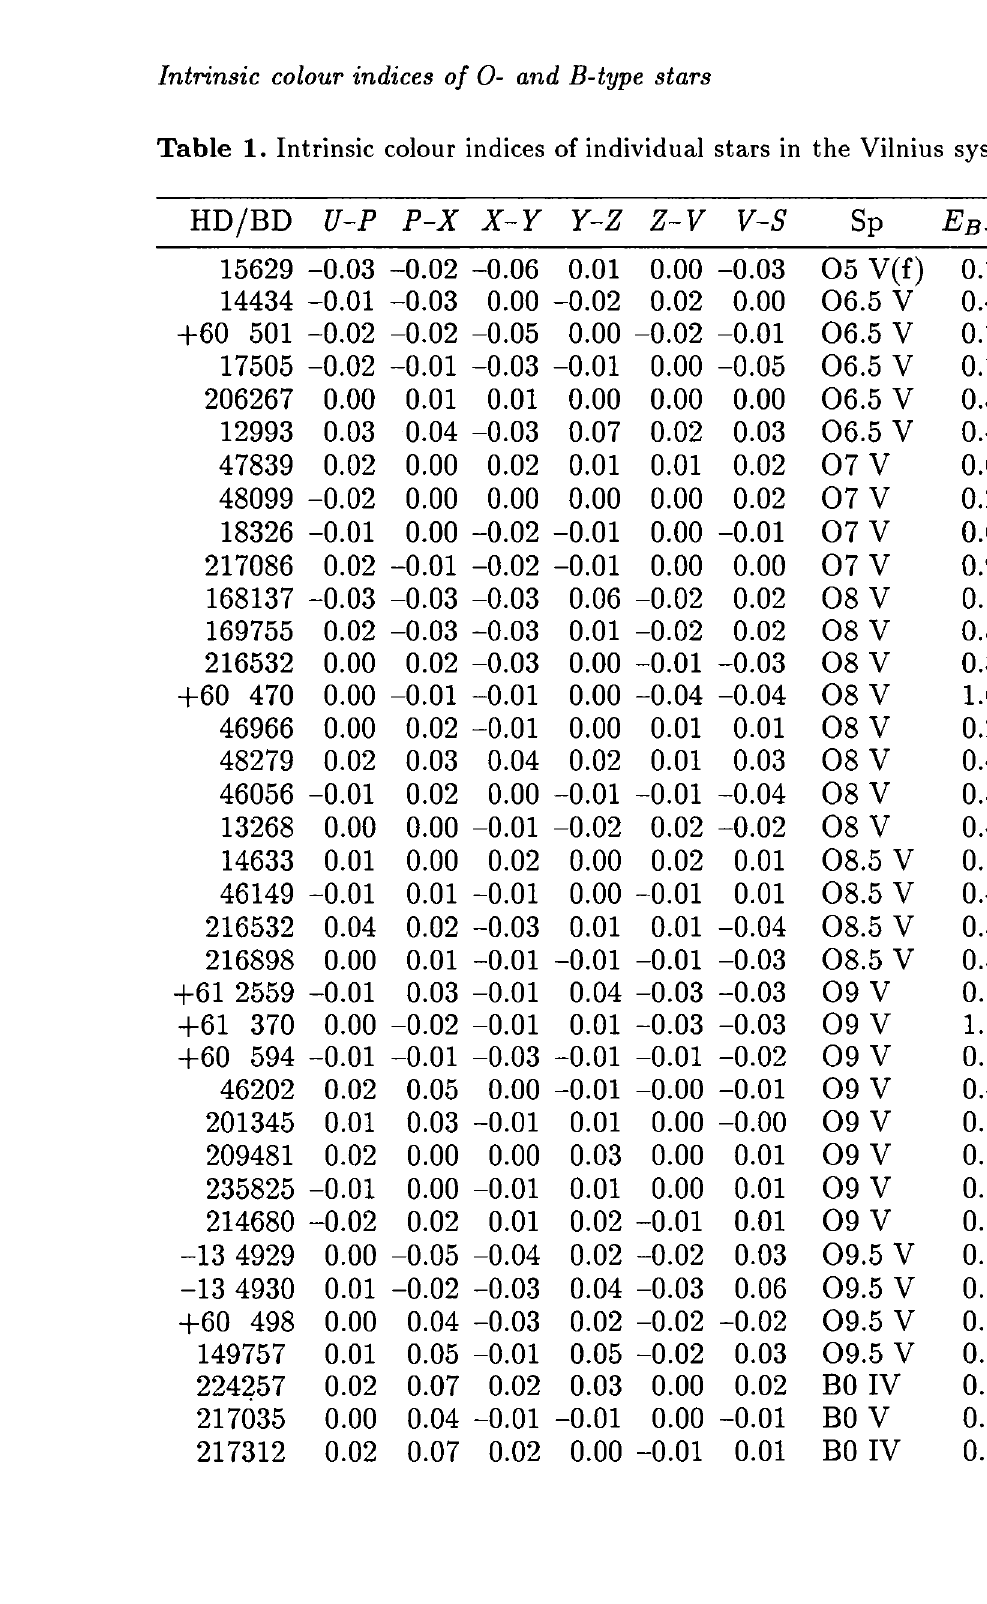
Table 1. Intrinsic colour indices of individual stars in the Vilnius